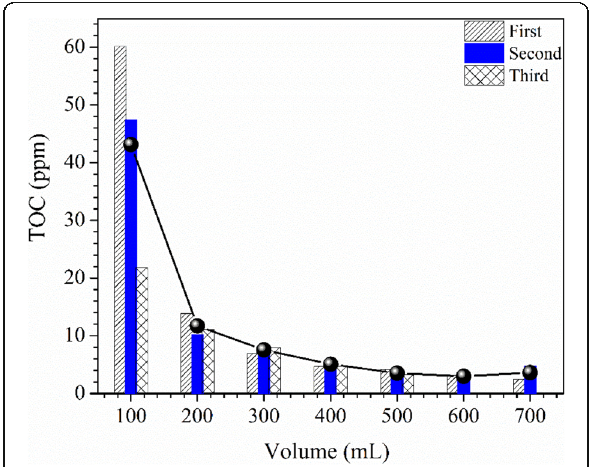
Fig. 2 TGA curves of the functionalized samples before and after washing